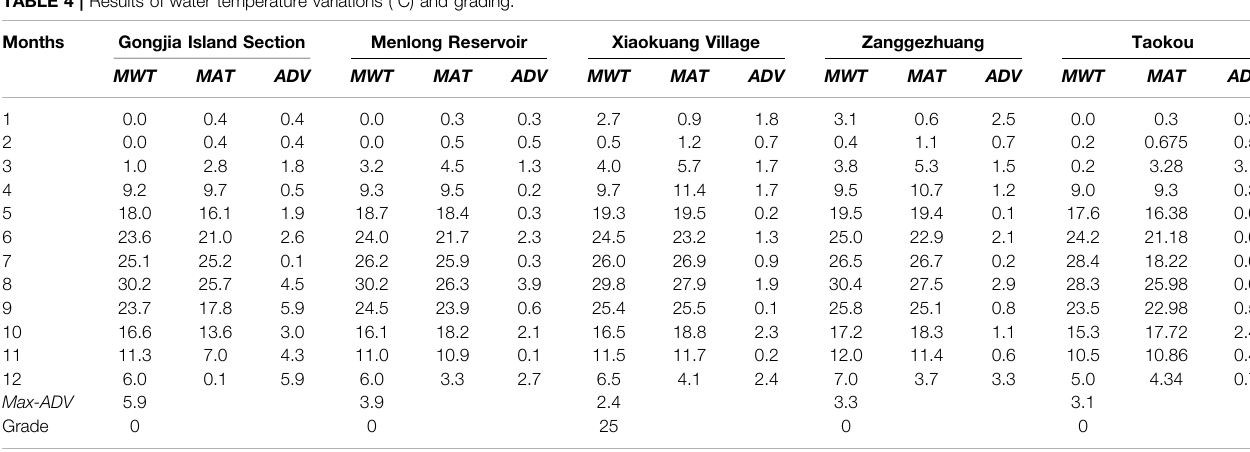
TABLE 4 | Results of water temperature variations ( ° C) and grading.